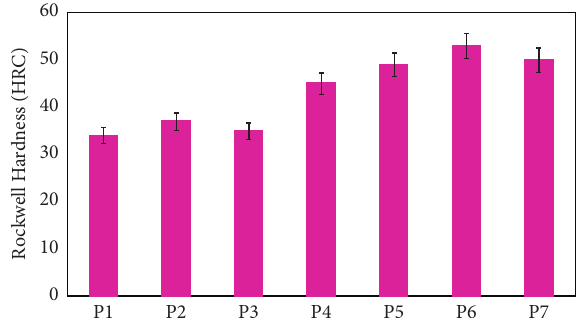
Figure 12: Rockwell hardness (HRC) values of the pure PLA and hybrid composite samples.